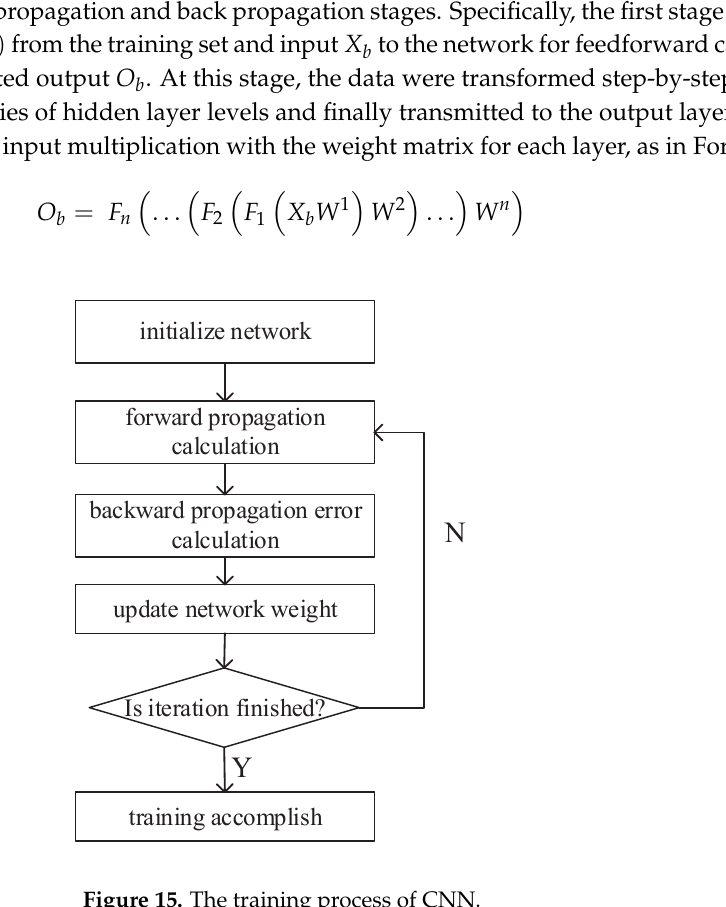
Figure 15. The training process of